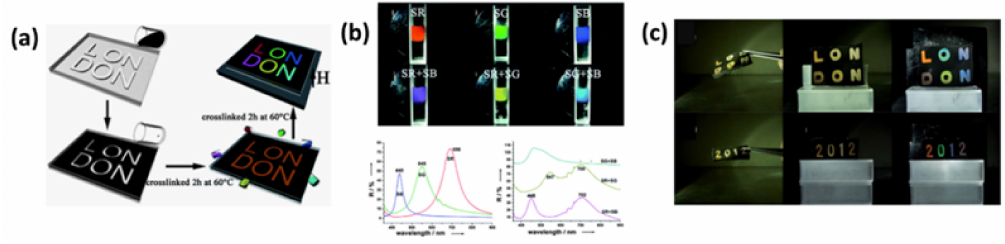
Figure 2. Visible magnetic-responsive Photonic crystals (PC) patterns for anti-counterfeiting based on the transition from disorder to order. ( a ) Schematic illustrations for fabricating anti-counterfeiting PC patterns. ( b ) Magnetic-responsive PC patterns containing uniform nanoparticles with one or two sizes had one or two photonic band gaps (PBGs), respectively, but displayed single colors. ( c ) The large color contrast of PC patterns appeared when applying the external magnetic field. Reused with permission from Reference [23], Copyright 2012, The Royal Society of